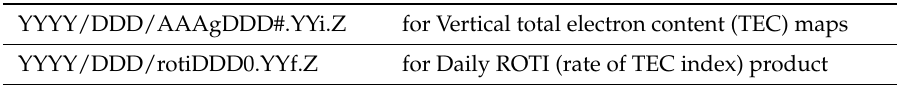
Table 2. IGS IONO WG VTEC product access.